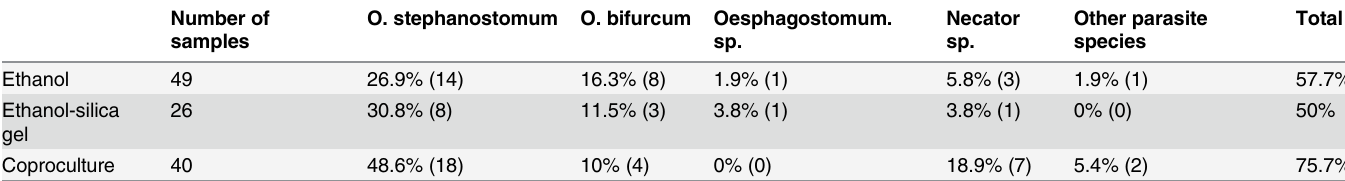
Table 1. Percentages of samples positive for different parasite species according to the sample storage method.